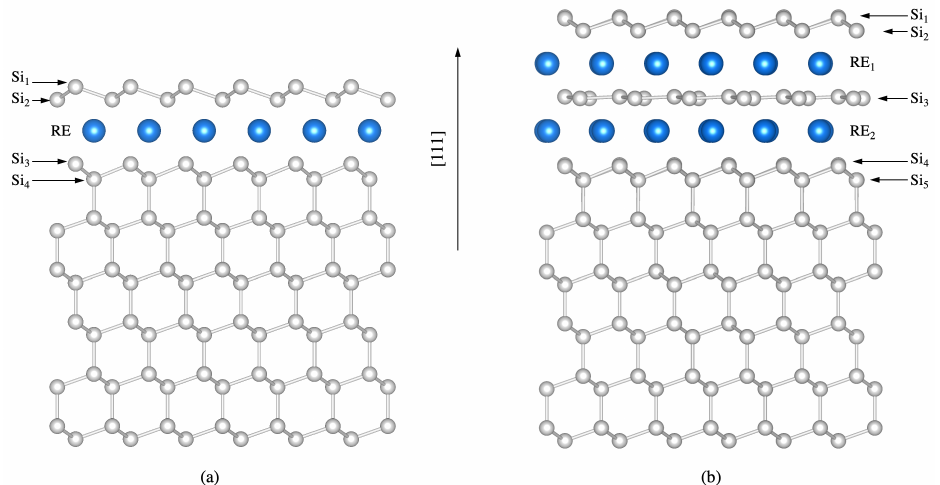
Figure 4. ( a ) Structural model of the rare-earth silicide monolayer with (1 × 1) periodicity on the Si(111) surface. ( b ) Rare-earth silicide bilayer with ( atoms are white, rare-earth atoms are blue. The topmost Si atomic layers are labeled by Si 1 -Si 5